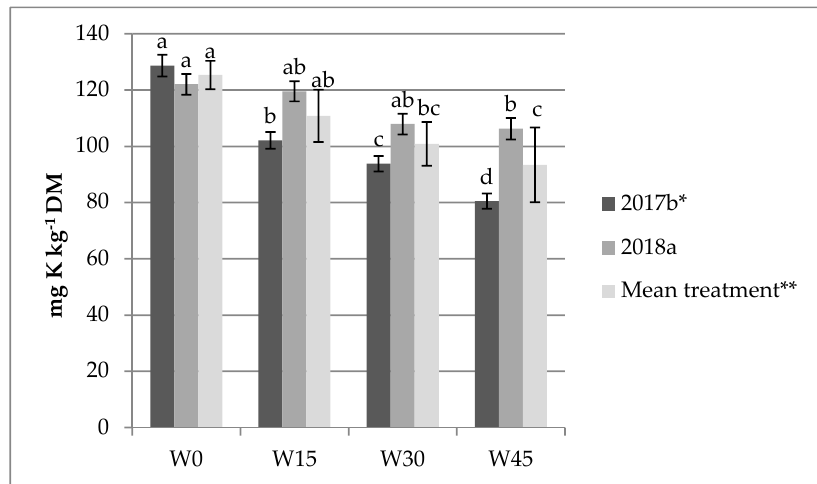
Figure 11. Available K content in soil. W0—the control with no stillage treatment, W15—15 m 3 of stillage per hectare, W30—30 m 3 of stillage per hectare, W45—45 m 3 of stillage per hectare. * means of years regardless of treatments; ** means of treatments regardless of years. The same letter means not significantly di ff erent.